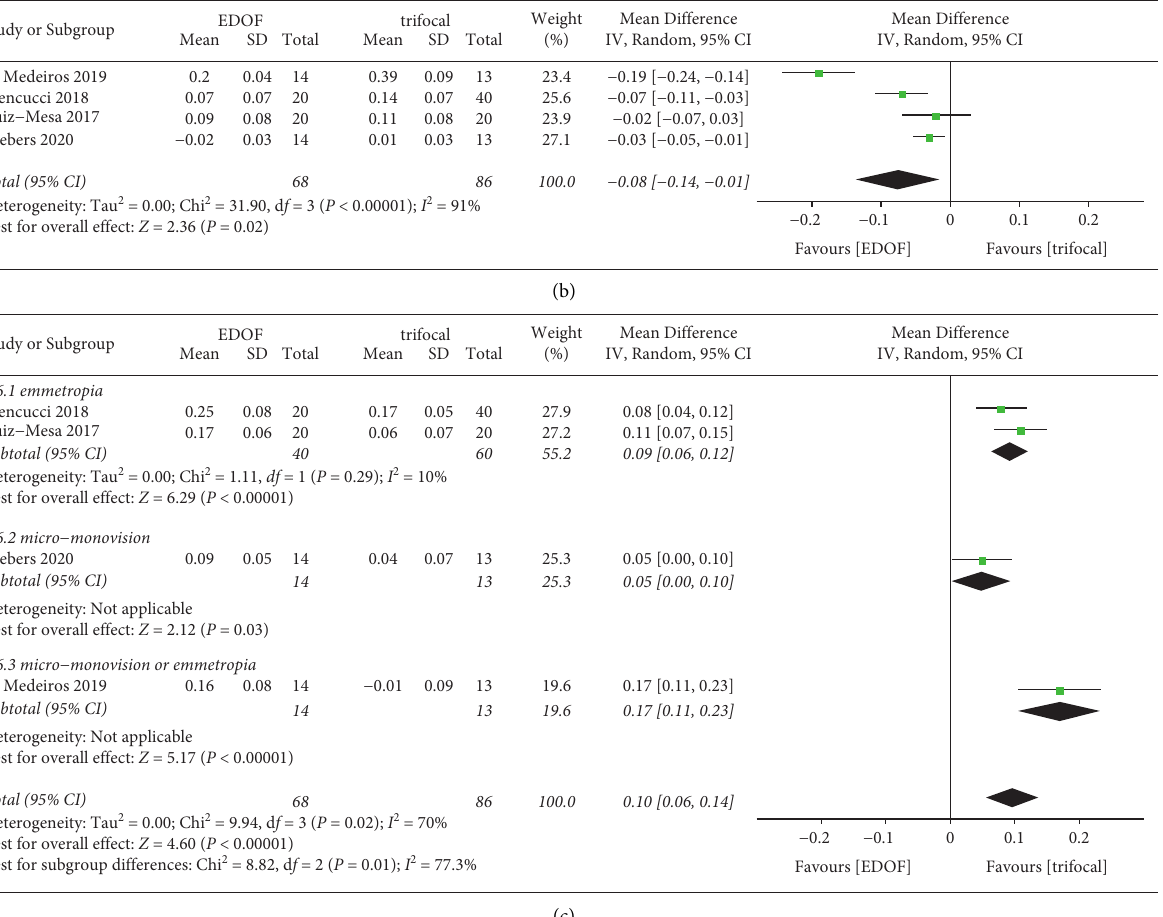
Figure 5: Forest plot of binocular uncorrected visual acuity. (a) Uncorrected distance visual acuity; (b) uncorrected intermediate visual acuity; and (c) uncorrected near visual acuity. EDOF, extended depth-of-focus; SD, standard deviation; CI, confidence interval; IV, inverse